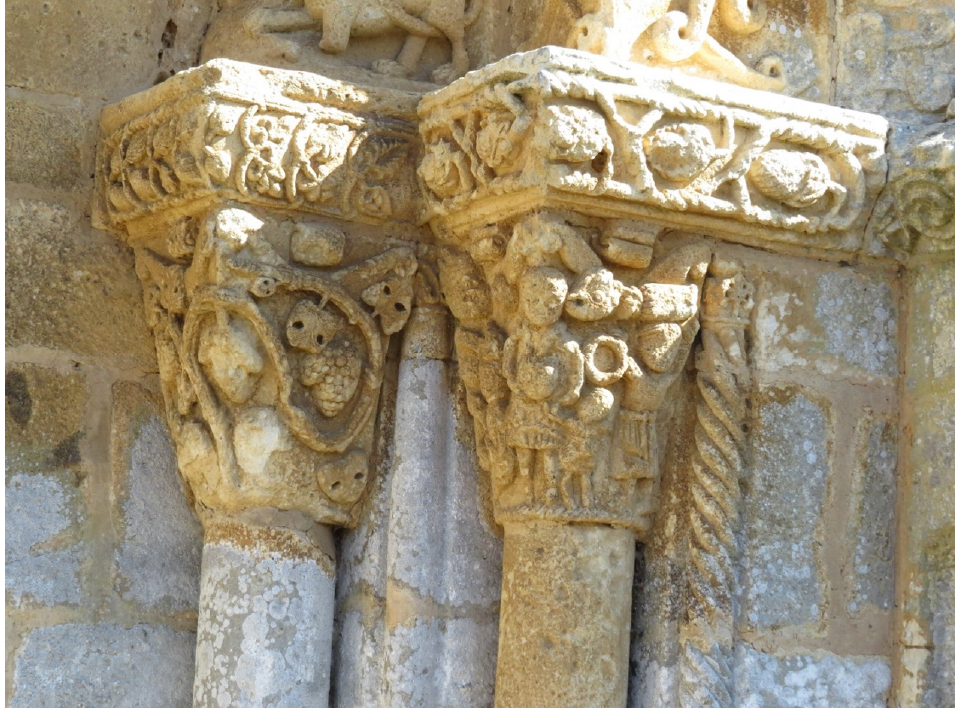
Figure 14. Vines and historiated capital, detail of right-hand side, west façade, Saint-Martin Church ,